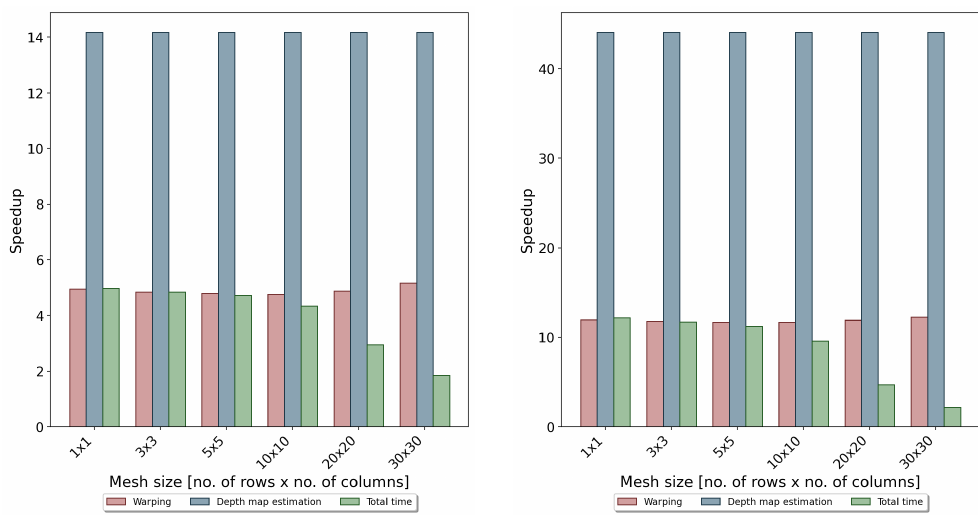
Figure 10. Results of the performance evaluation—speedup obtained by using the parallelisation of the algorithms using a GPU: results for a notebook ( left ) and desktop ( right ). Table 2. Average value of vertical disparity (in px) for all frames in the movie—before (raw) and after (rectified)